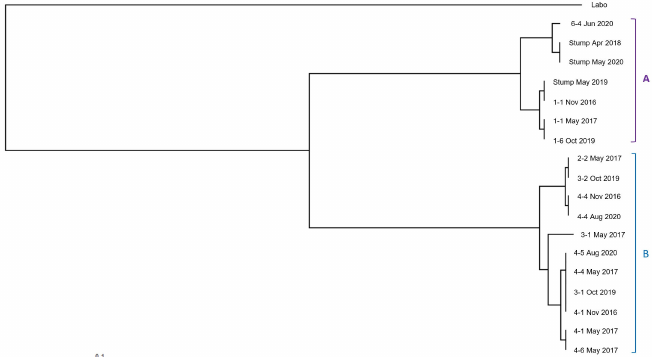
Figure 8. Dendrogram obtained using UPGMA between cohorts of Coptotermes formosanus collected in Isogi Park. Cohorts from the same population are labeled A and B.